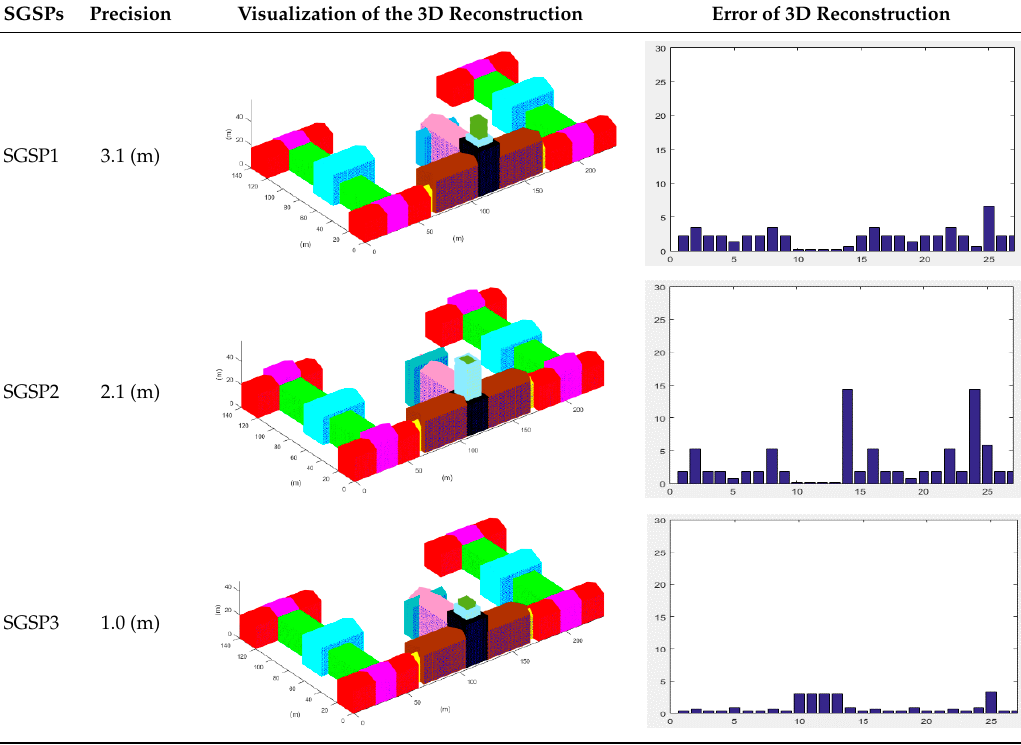
model of the building, not each single unit. Therefore, the objective function f in Equation (5) needs no